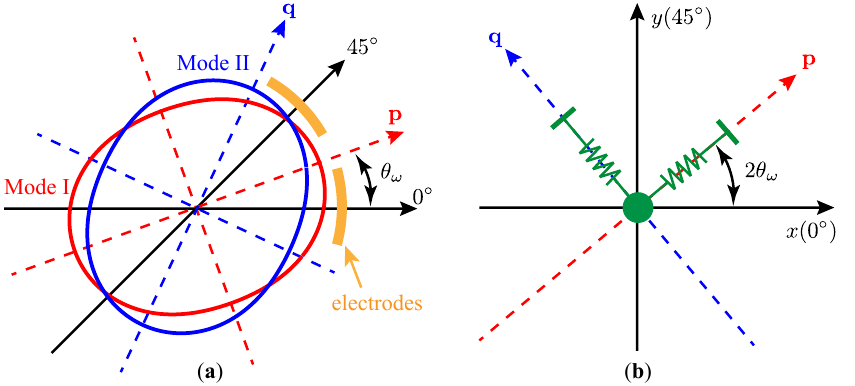
Figure 2. Displacements of the resonator. ( a ) in geometry; ( b ) from the perspective of capacitive